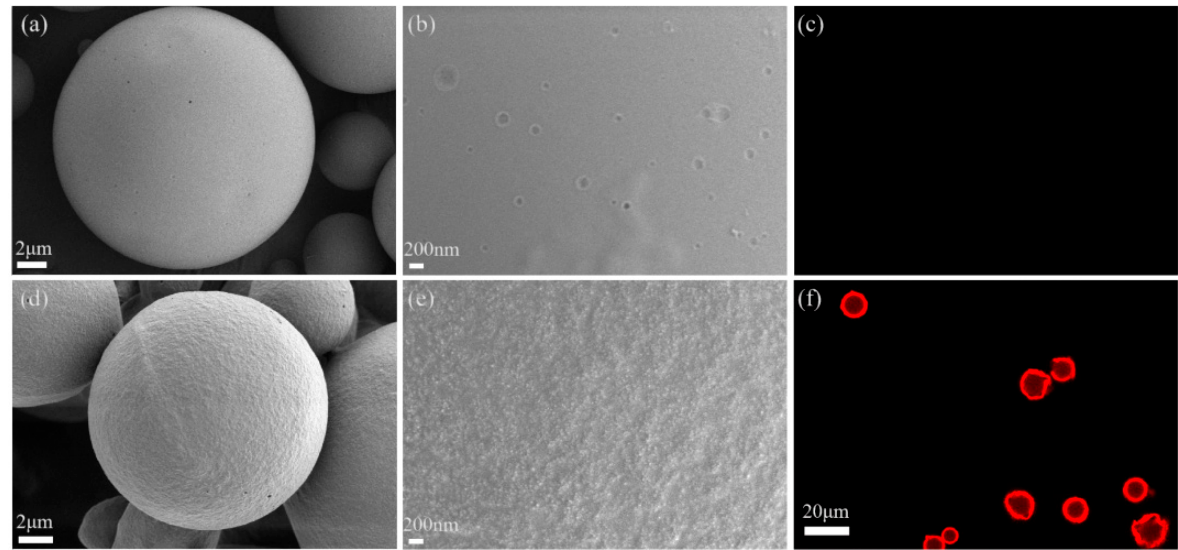
Figure 4. The morphologies of PLGA microspheres and the nanomicelle-microsphere complexes were observed by SEM and CLSM. ( a ) Morphology of PLGA microspheres by SEM (×4 k); scale bar is 2 μ m; ( b ) Surface image of PLGA microspheres by SEM (×20 k); scale bar is 200 nm. ( c ) Morphology of PLGA microspheres by CLSM (×40 k); ( d ) Morphology of the nanomicelle-microsphere complexes by SEM (×5 k); scale bar is 2 μ m; ( e ) Surface image of the nanomicelle-microsphere complexes by SEM (×20 k); scale bar is 200 nm; ( f ) Morphology of the nanomicelle-microsphere complexes by CLSM (×40 k); scale bar is 20 μ m.